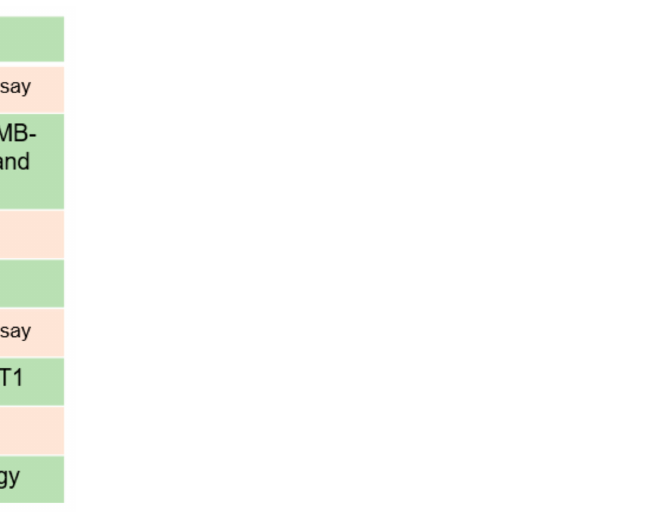
Figure 1. The flow chart of the studies in bioguided fractionation of local plants to identify Matrix Metalloproteinase9 (MMP9) inhibitors and breast cancer cytotoxic agents.